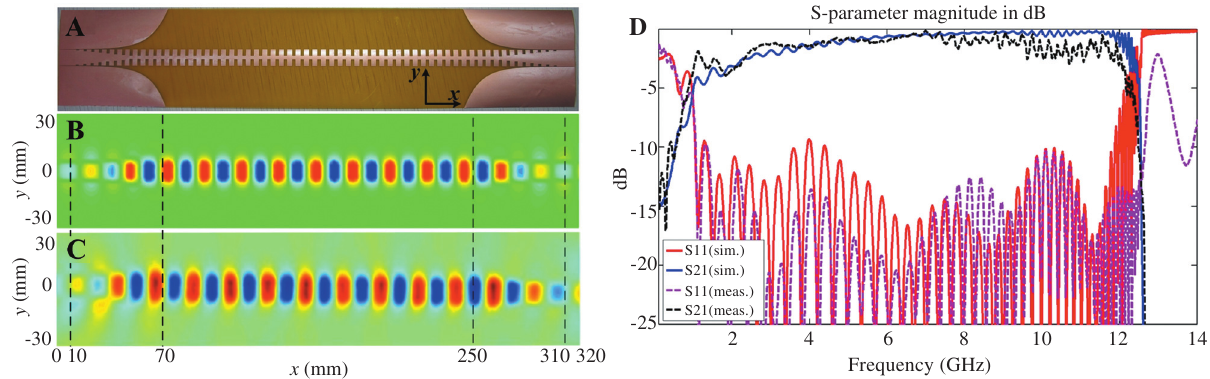
Figure 15: (A) Photo of the fabricated hybrid waveguide using FCCL. (B, C) Simulation and measured surface electric field of the hybrid waveguide, respectively. (D) The simulation and measurement S parameters of the hybrid waveguide with matching transition. Reproduced from [43] with